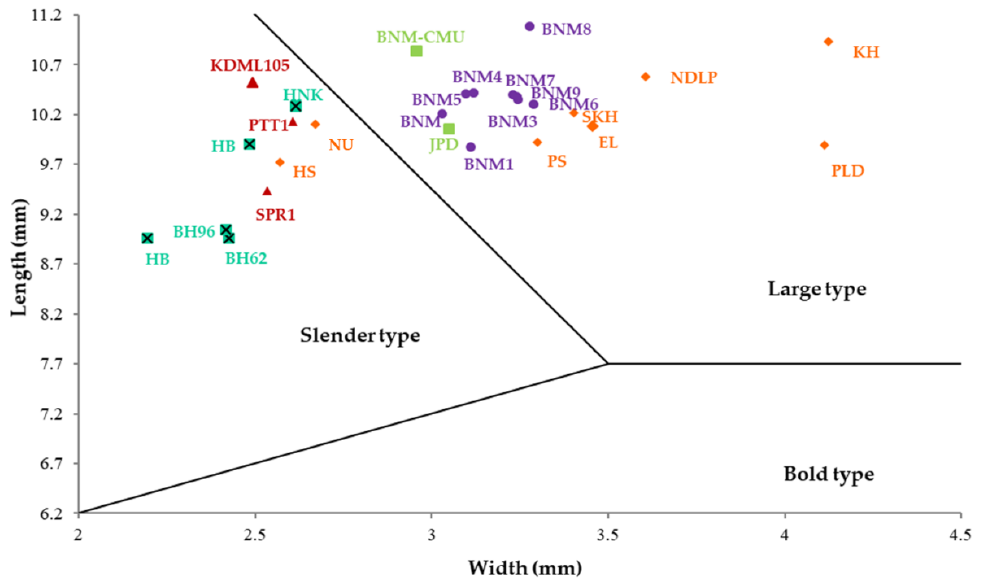
Figure 1. Shape of unhusked grains of 22 fragrant rice landrace varieties, with 2 breeding line varieties, and 3 check varieties, classed with the scheme of Matsuo (1952). Different colors and symbols identify different regions and rice groups: The nine purple circles, northern; the eight orange diamonds, the northeastern; the five blue squares, the southern; the two light green squares, promising landraces; and the three red triangles, elite fragrant varieties. Table 3. Seed morphology of 22 landrace fragrant rice varieties, 2 breeding line varieties, and 3 check varieties.